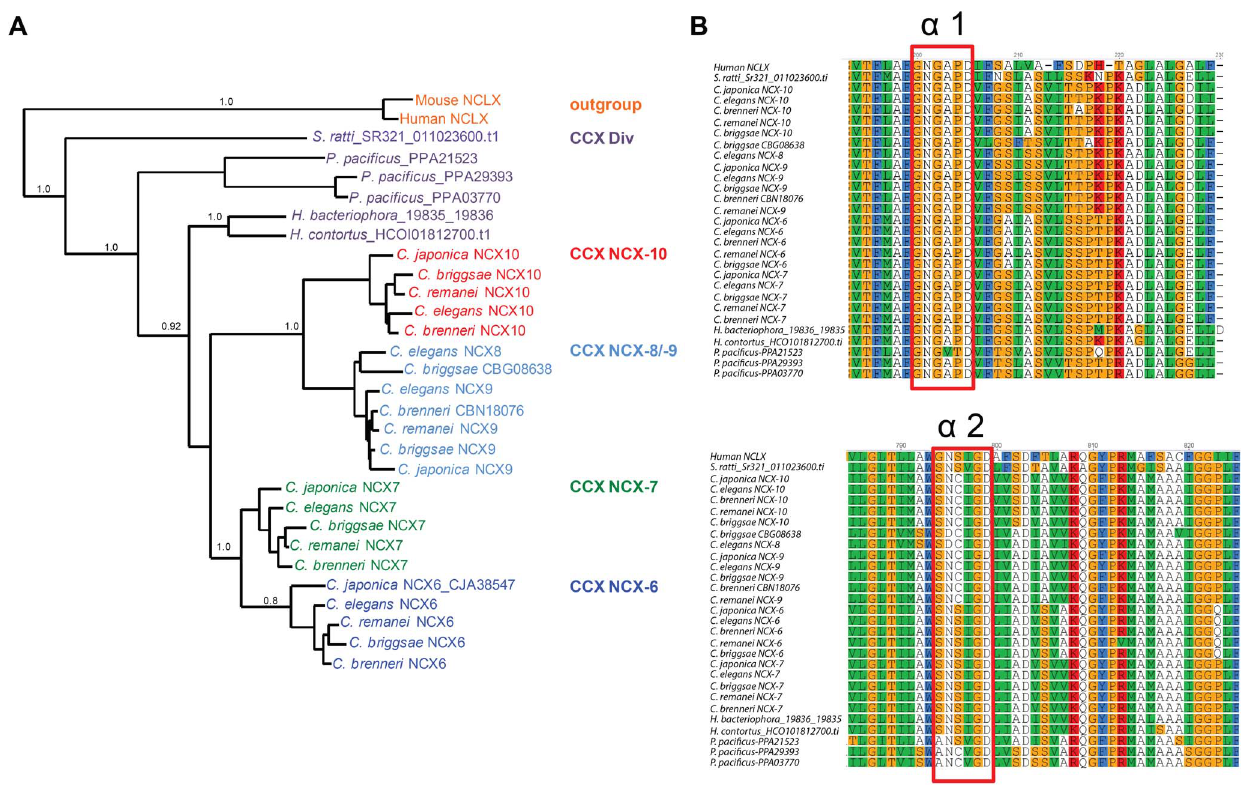
Figure 5. Phylogenetic analysis of NCLX (CCX) exchangers from various nematodes. ( A ) Phylogenetic analysis of NCLX type exchangers from Strongyloides ratti, Haemonchus contortus, Heterorhabditis bacteriophora, Caenorhabditis elegans, Caenorhabditis brenneri, Caenorhabditis japonica, Caenorhabditis briggsae, Caenorhabditis remanei , and Pristionchus pacificus . Inferred phylogeny was constructed using PhyML [38] using the model WAG + I + G + F determined from Prottest [36] and derived from amino acid alignments using MUSCLE [35]. ‘CCX div’ denotes a divergent CCX cluster that does not group with the Caenorhabditis CCX protein clusters (i.e. NCX-6 to NCX-10). The NCLX exchanger from human and mouse were used as an outgroup. ( B ) Alignment of a repeat domains within CCX (NCLX) proteins from various nematodes and also human NCLX. Alignments were generated using MUSCLE [35] of NCLX type exchangers from Human, S. ratti, H. contortus, H. bacteriophora, C. elegans, C. brenneri, C. japonica, C. briggsae, C. remanei , and P. pacificus